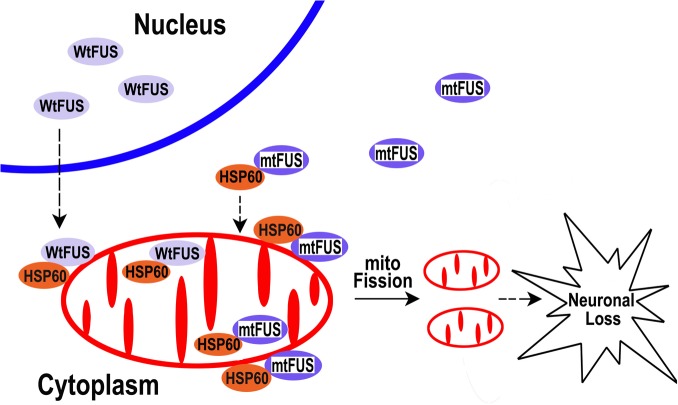
A working model for FUS-induced neurotoxicity.Either an aberrant increase in the expression of Wt-FUS (WtFUS) or FUS mutations that enhance the cytoplasmic redistribution of the mutant FUS protein (mtFUS) leads to abnormal accumulation of cytoplasmic FUS and increased translocation to mitochondria, resulting in excessive mitochondrial fission and damage that eventually culminate in neuronal death.